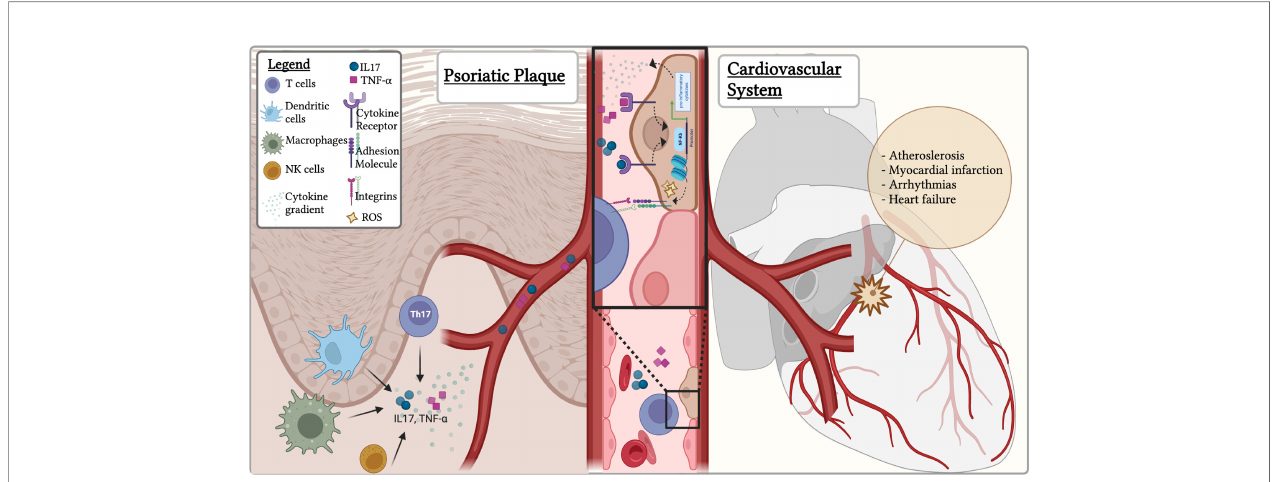
FIGURE 1 | The immune-mediated pathogenetic link between psoriasis and cardiovascular disorders: triggering the endothelial dysfunction. In the psoriatic plaque, immune cells, including Th17 promote the generation and release of circulating in fl ammatory mediators as IL-17 and TNF- a . TNF- a caused NF- k B activation, subsequently leading to increased expression of multiple pro-in fl ammatory cytokines in the psoriatic skin. In endothelial cells, IL-17A receptor drives the production of TNF- a , IL-1 b , CCL2, and the expression of ICAM- 1 leading to the endothelial dysfunction involved in the pathophysiology of multiple immune-mediated CVDs. The IL-17 also triggers the accumulation of ROS, in particular O − 2 within the endothelium further contributing to endothelial dysfunction and CVD